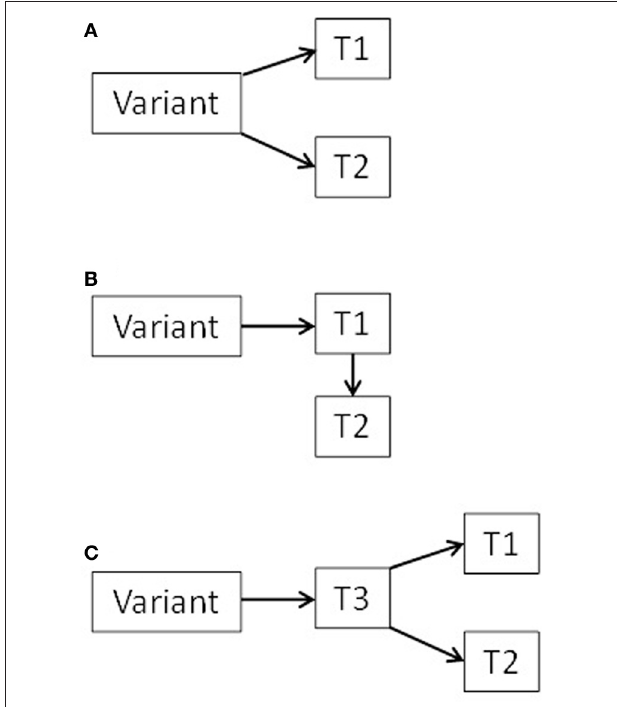
FIGURE 2 | Diagram of three possible scenarios (A, B, and C) for pleiotropic bone-muscle interactions ( T = trait).